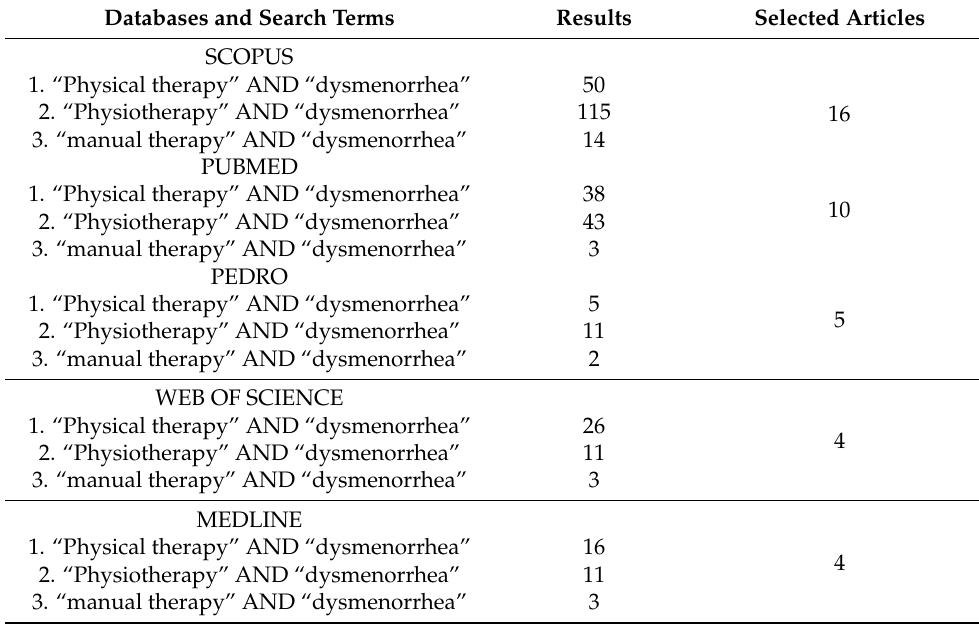
Table 1. Search strategies in the different